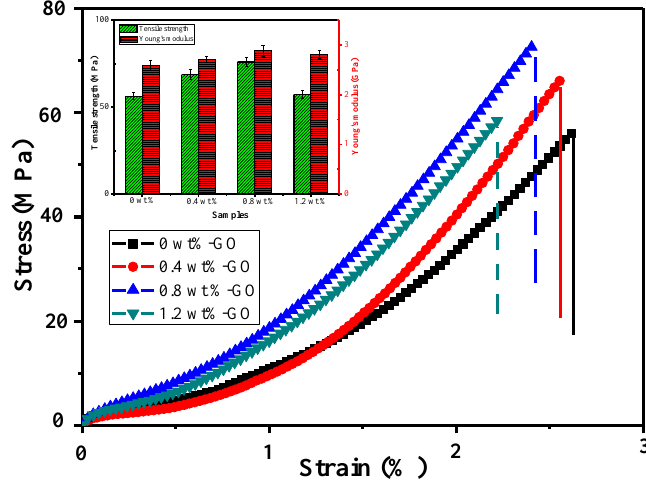
Figure 7. Stress-strain curves of the GO-toughened epoxy resin.